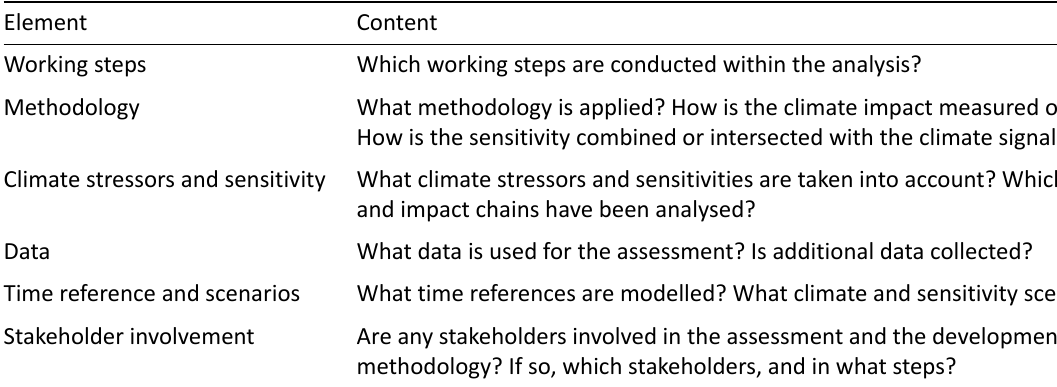
Table 1. Conceptualisation of the input. Element